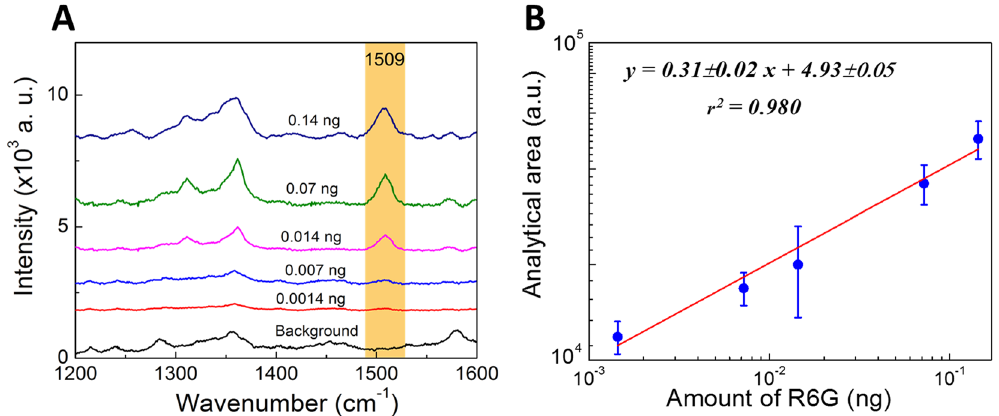
Figure 8. Detection sensitivity of the office paper plasmonic substrate with AgNSs. ( A ) R6G SERS spectra with 2 × 10 9 NPs/mm 2 of AgNSs drop-cast in office paper. Background, well without R6G, i.e., only AgNSs in office paper; amounts of R6G were varied in the range 10 − 3 –10 − 9 M i.e . 1 × 10 3 –1 × 10 − 3 ng (only 1 × 10 − 7 –1 × 10 − 9 M i.e . 1 × 10 − 1 –1 × 10 − 3 ng, are represented). Areas were calculated for the 1509 cm − 1 vibrational line (yellow band). ( B ) Correlation between logarithmic SERS band areas at 1509 cm − 1 (due to C-C stretching vibration is highly sensitive to the amount of R6G) and logarithmic R6G amounts. Each data point represents the average value from three SERS spectra. Error bars represent the